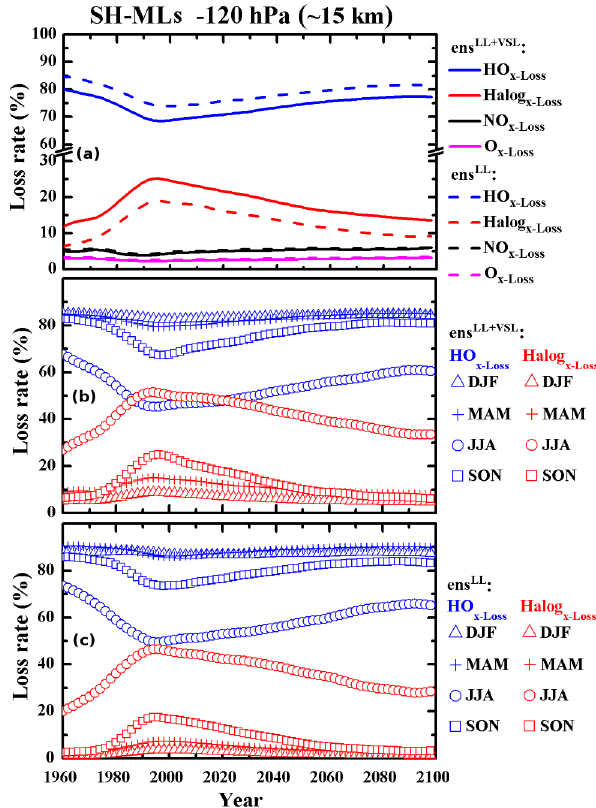
Figure 8. Temporal evolution of the contribution percentages from different ozone-depleting families (O x-Loss , NO x-Loss , HO x -Loss , Halog x -Loss ) to the total odd-oxygen loss rate in the lowermost stratosphere (120hPa) at SH-MLs. Panel (a) shows the annual mean contribution of each ozone-depleting family for the experiments with (solid line; ens LL + VSL ) and without (dashed line; ens LL ) VSL Br sources. Panels (b) and (c) show the seasonal mean contri- butions of both HO x -Loss and Halog x -Loss for the experiments with and without VSL Br sources,